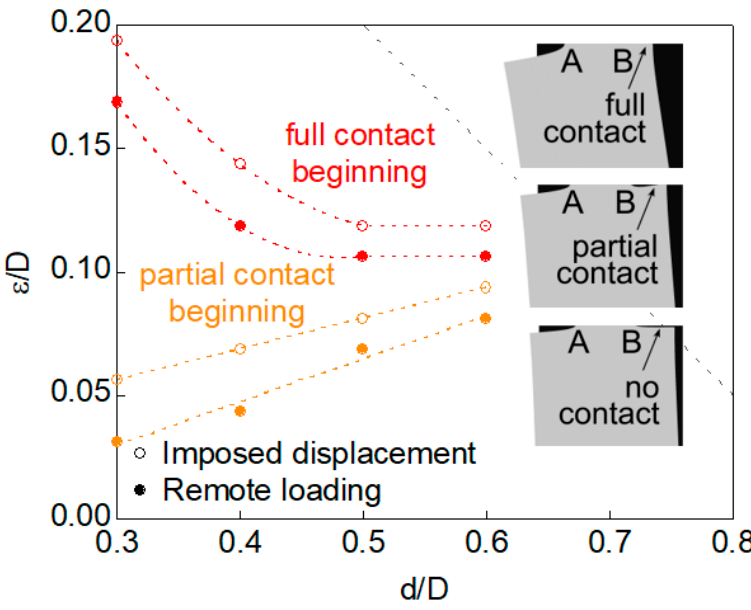
Figure 5. Curves ε / D vs. d / D for the beginning of partial contact and full contact . (ii) full contact in the cases of values of relative ligament diameter d / D ≤ 0.6 (the same interval as in the case of a partial contact) and from certain eccentricity level ε / D (this level being lower as d / D increases, following curvilinear relationship tending to a horizontal asymptotic level, as shown in Figure 5 in the matter of full contact